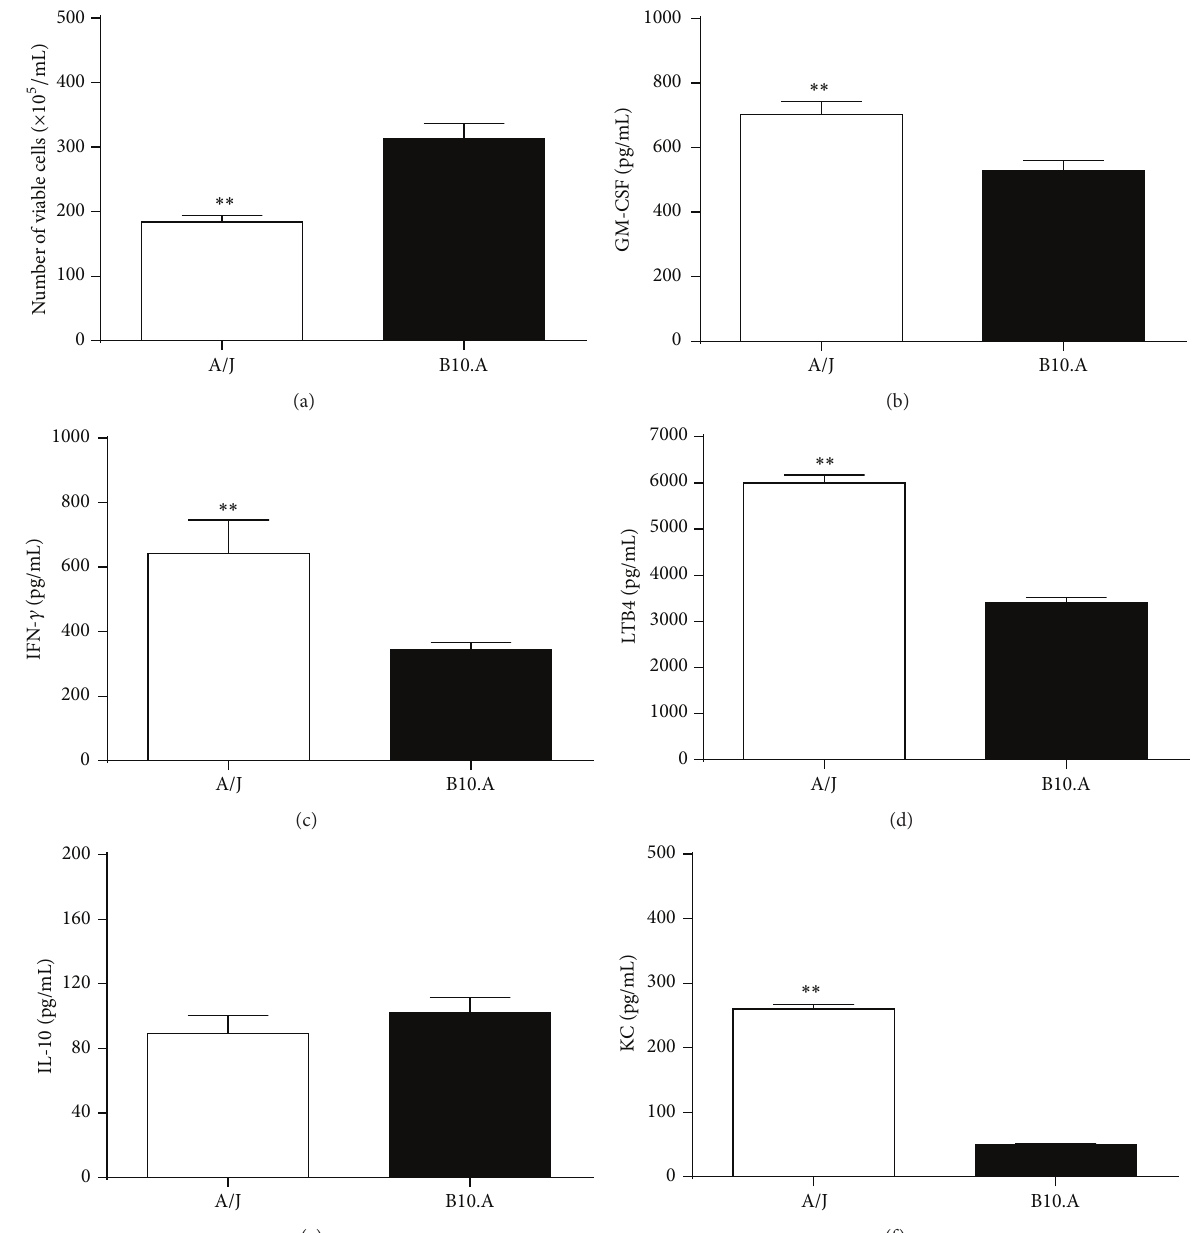
Figure 6: Number of viable Pb and concentration of soluble mediators after 13 days of subcutaneous inoculation in A/J resistant and B.10A susceptible mice: (a) colony forming units of Pb ; levels of (b) GM-CSF, (c) IFN- 𝛾 , (d) LTB4, (e) IL-10, and (f)